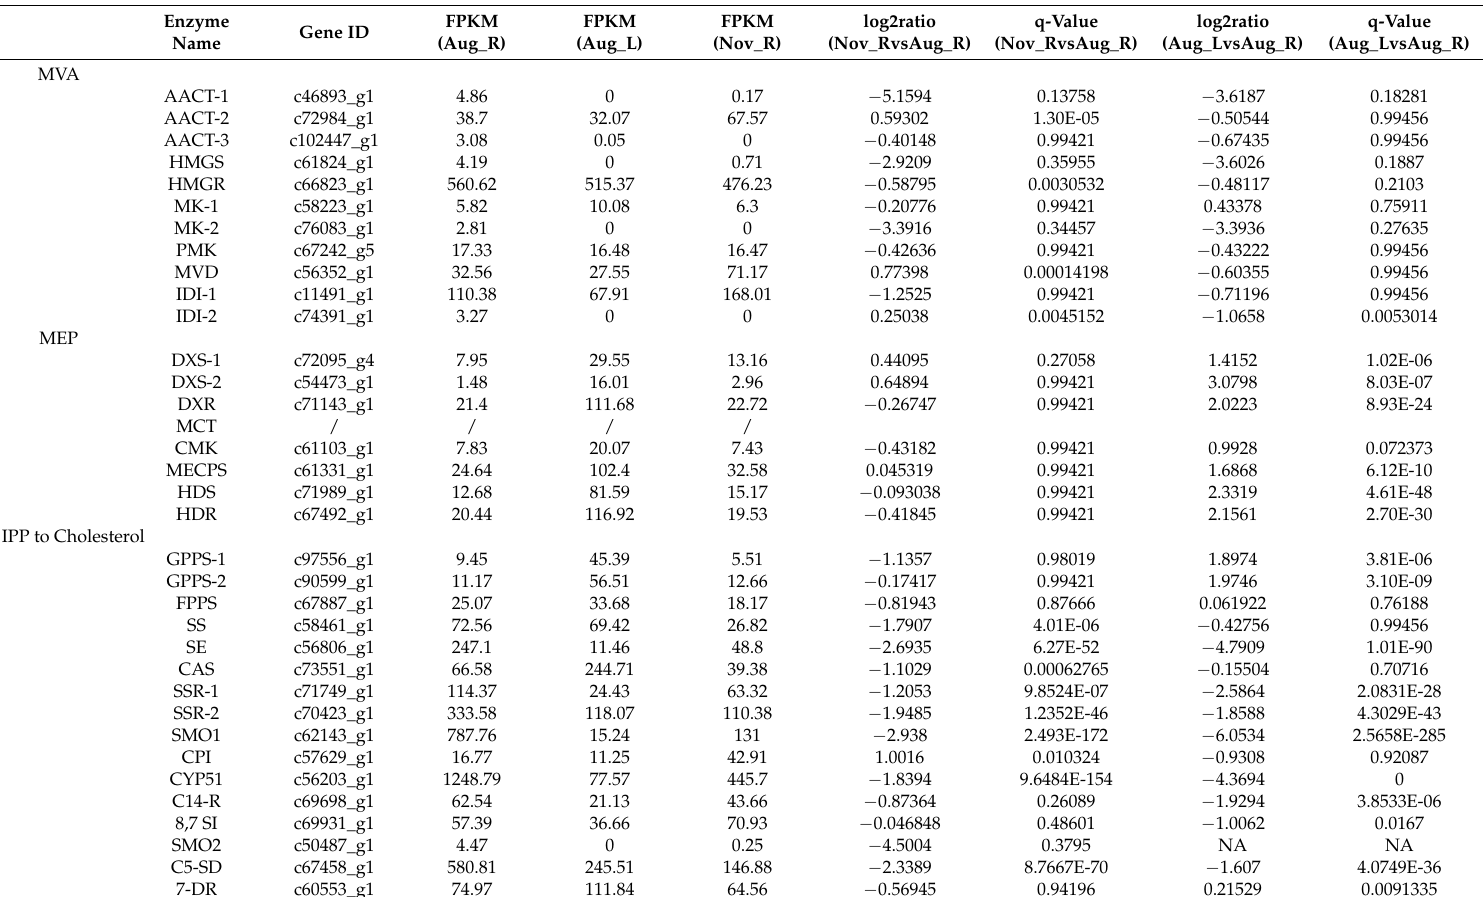
Table 2. Transcriptomic comparison of putative cholesterol pathway genes across different tissues of D.